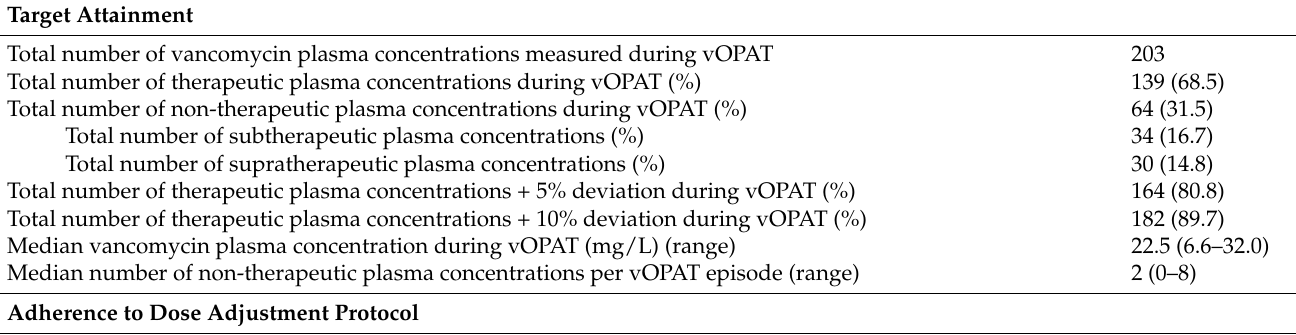
Table 4. Summary of data on therapeutic drug monitoring, clinical outcome and adverse